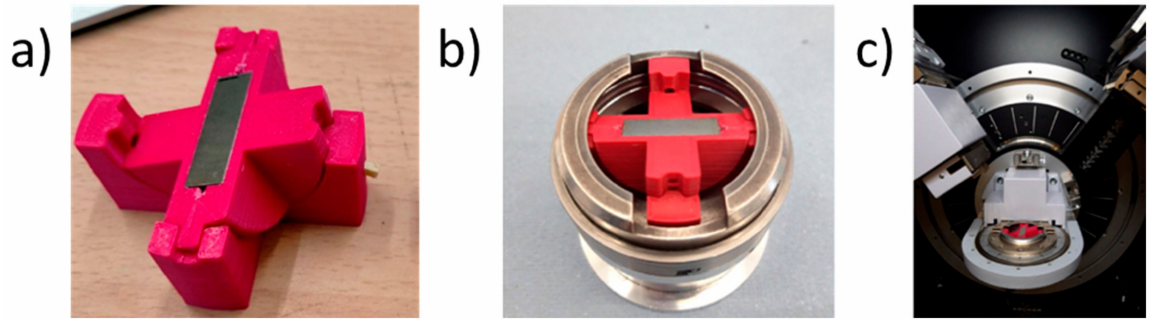
Figure 2. The details of X-ray diffraction ( sin 2 ψ ) technique realization: ( a ) goniometer-like setup; ( b ) setup embedded into diffractometer grip; and ( c ) setup with grip into